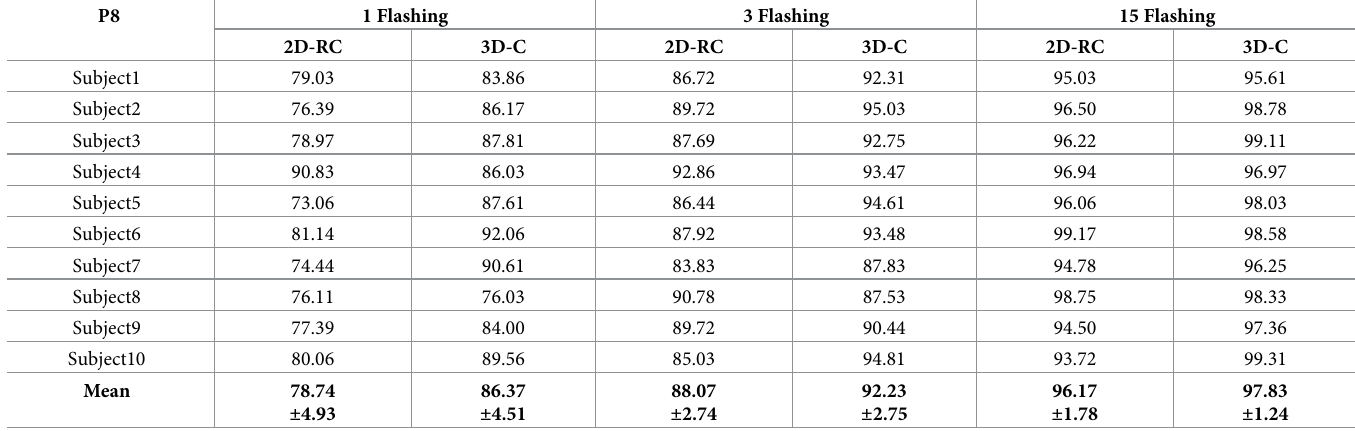
Table 2. P8 electrode accuracy